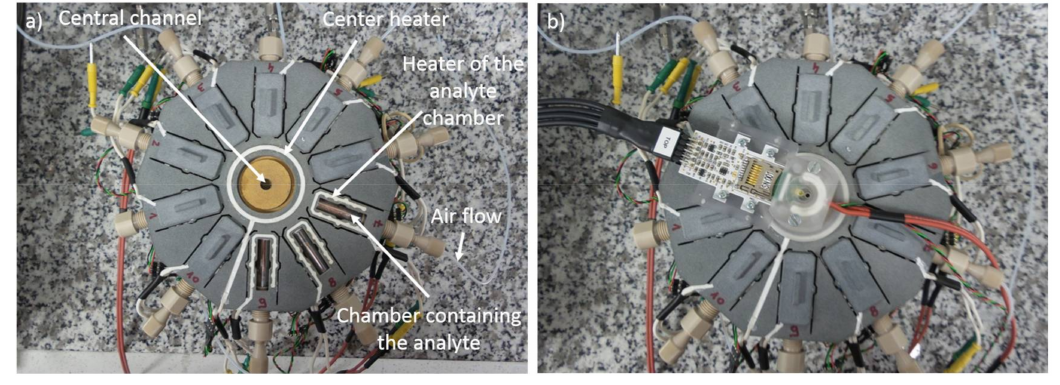
Figure 2. Vapor generator device ( a ) without; ( b ) with the cantilever